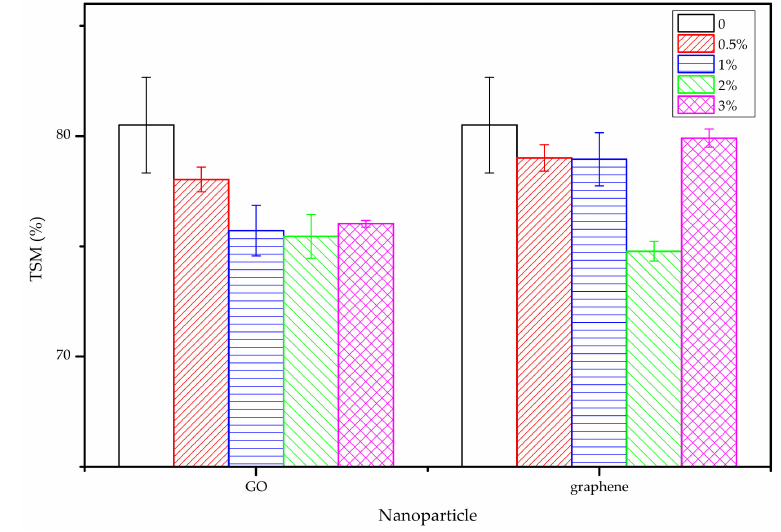
Figure 5. Total soluble mass (TSM) results for the blend